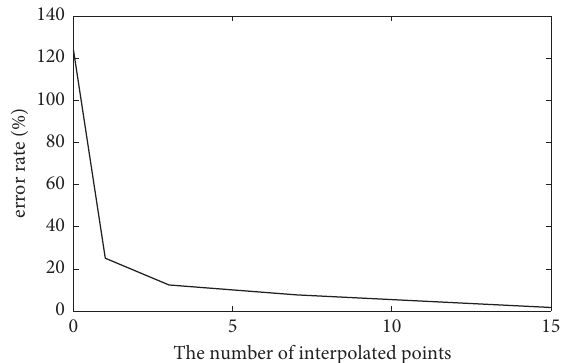
Figure 7: The error rate of the interpolated point in adjacent sampling